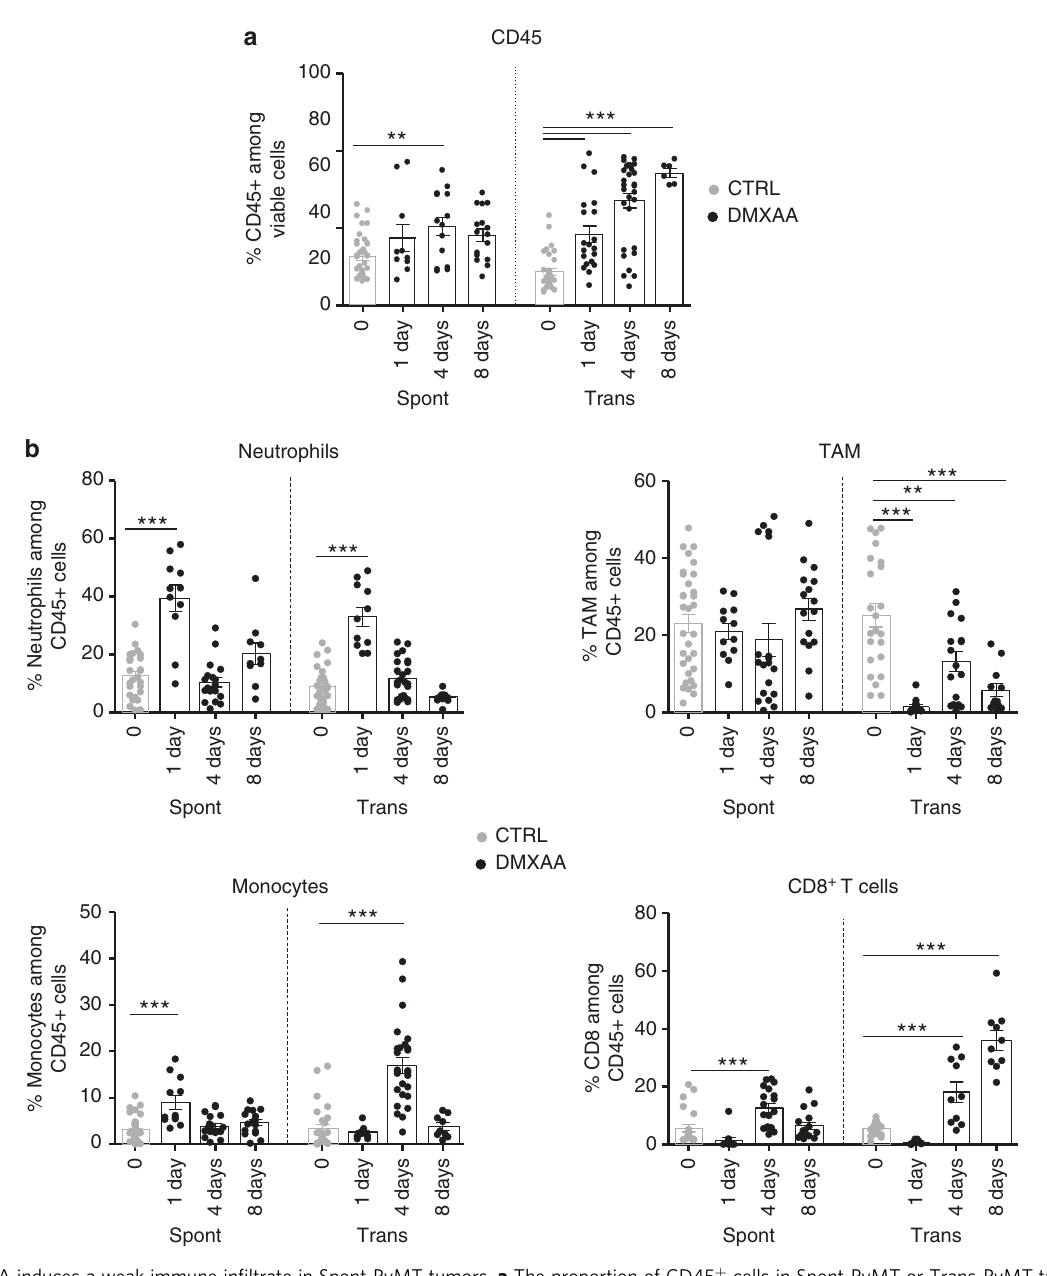
Fig. 2 DMXAA induces a weak immune in fi ltrate in Spont-PyMT tumors. a The proportion of CD45 + cells in Spont-PyMT or Trans-PyMT tumors before treatment (gray circles) and at days 1 to 8 after DMXAA i.p. injection (black circles) was determined by fl ow cytometry after dissociation of the tumors. b The proportion of neutrophils, TAM, monocytes, and CD8 + T cells among those CD45 + cells are shown. For day 0, Spont-PyMT n = 12 and Trans-PyMT n = 30 mice, for day 1 Spont-PyMT n = 6 and Trans-PyMT n = 12, for day 4 Spont-PyMT n = 9 and Trans-PyMT n = 24 and for day 8 Spont-PyMT n = 7 and Trans-PyMT n = 10. The data are from four to seven independent experiments for each group of mice. Results are expressed as mean ± SEM. Tukey ’ s multiple comparison test. * p < 0.05; ** p < 0.01; *** p < 0.001. Source data are provided as a Source Data fi